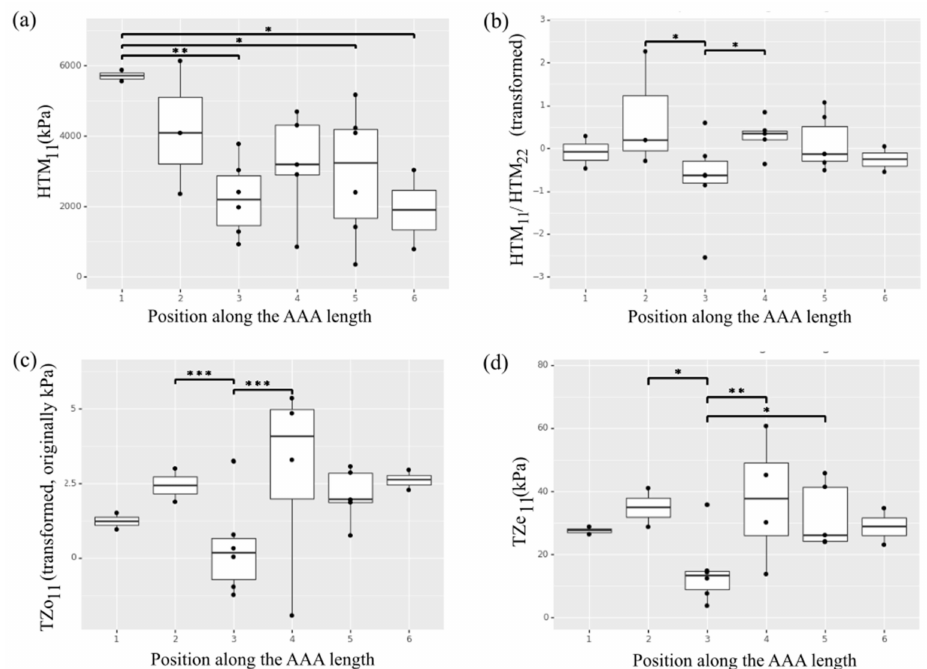
Figure 3. Heterogeneity of the selected ex vivo biaxial mechanical properties along the length of the AAA. ( a ) High tangential modulus (HTM) in the circumferential direction (11). ( b ) High tangential modulus anisotropy. ( c ) Transition zone onset (TZo) in the circumferential direction (11). ( d ) Transition zone end (TZe) in the circumferential direction (11). * indicates p value < 0.05, ** indicates p value < 0.01 and *** indicates p value <